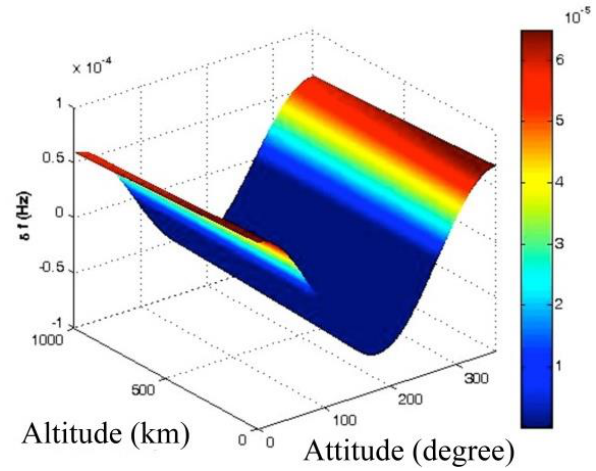
Figure 7. Attitude and altitude changes of host vehicle-induced clock